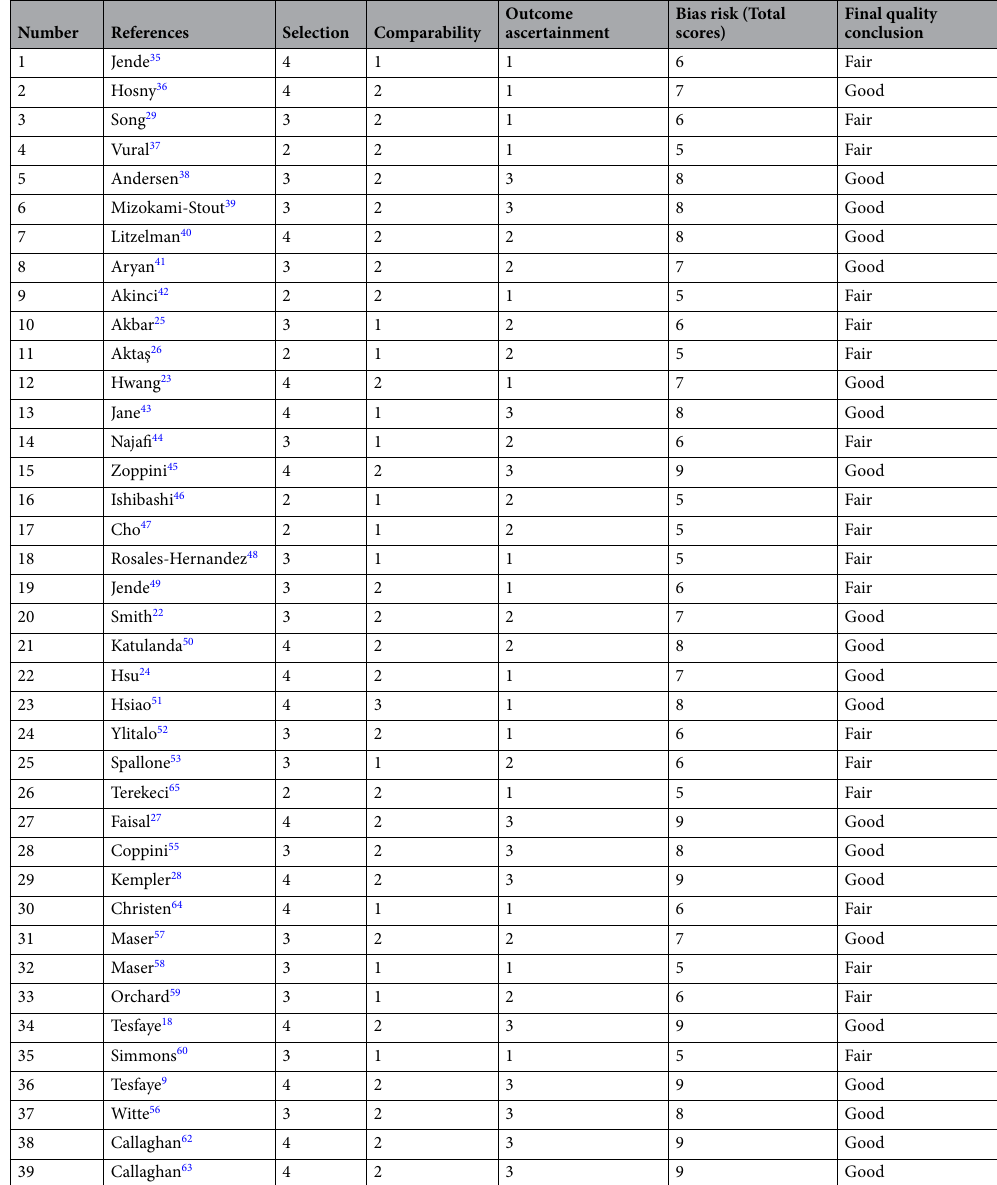
Table 2. Risk of bias analysis in each